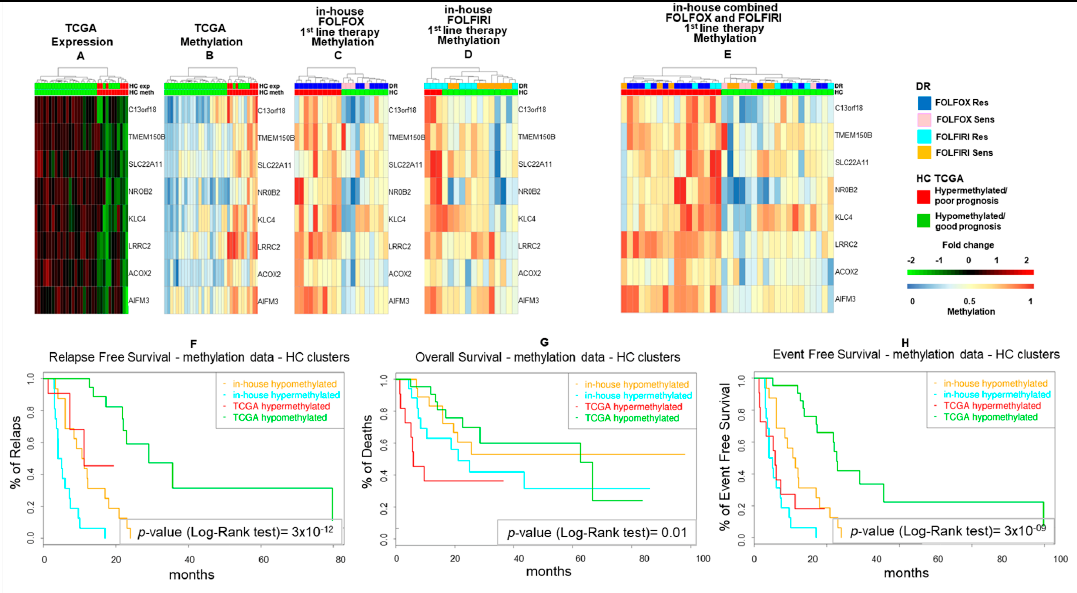
Figure 3. Hierarchical clustering and Kaplan–Meyer survival curves of mCRCs according to the eight-gene signature. ( A – E ). Heatmaps of functionally methylated (fMET) genes in TCGA COAD dataset ( A , B ) and in 1st-line FOLFOX ( C ), FOLFIRI ( D ) or combined FOLFOX/FOLFIRI ( E ) in-house datasets. ( A , B ). Differential gene expression ( A ) and methylation ( B ) profiles in TCGA COAD. ( C – E ). Methylation profiles in in-house cohorts. ( F – H ). Relapse-Free ( F ), Overall ( G ), and Event-Free ( H ) survival curves according to TCGA COAD or in-house clusters, as reported in ( A , B , E ). HC, hierarchical clustering; DR, drug response.